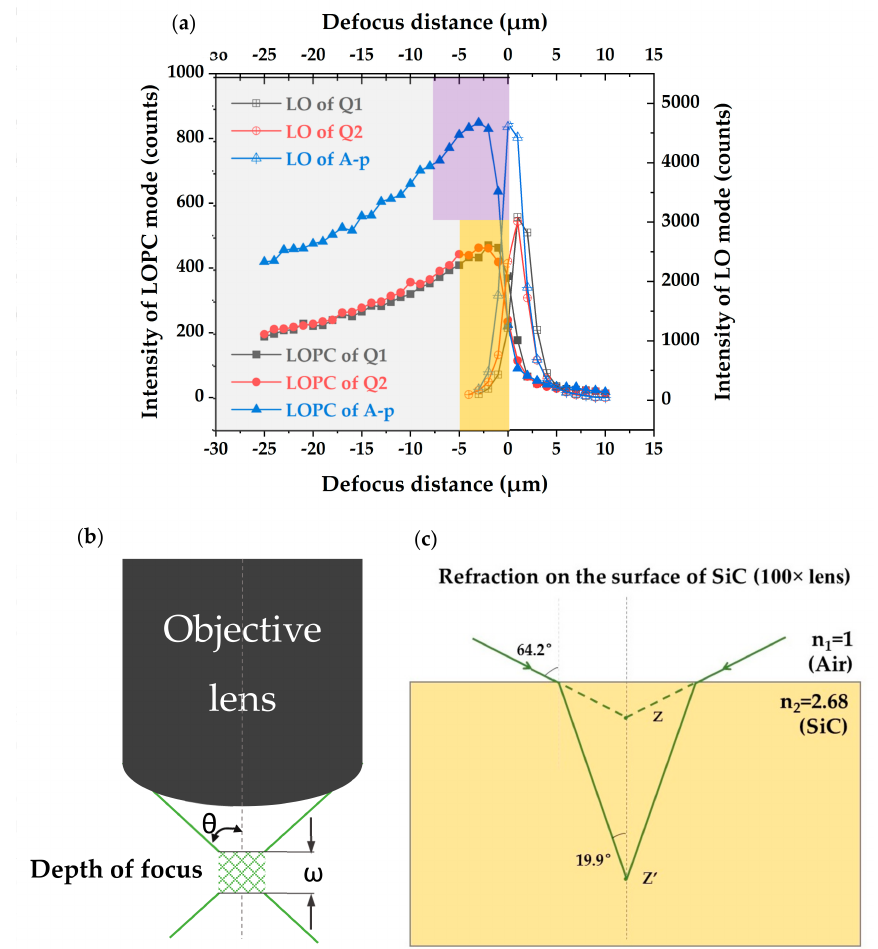
Figure 6. ( a ) Variation of the LO and LOPC peak position with the defocus distance using the 100 × lens (for sample Q1, Q2, and A p ). The step of depth profiling is 1 µ m. ( b ) Schematic diagram of the objective lens. ( c ) Schematic diagram of the refraction on the SiC substrate in depth profiling when using the 100 × lens.